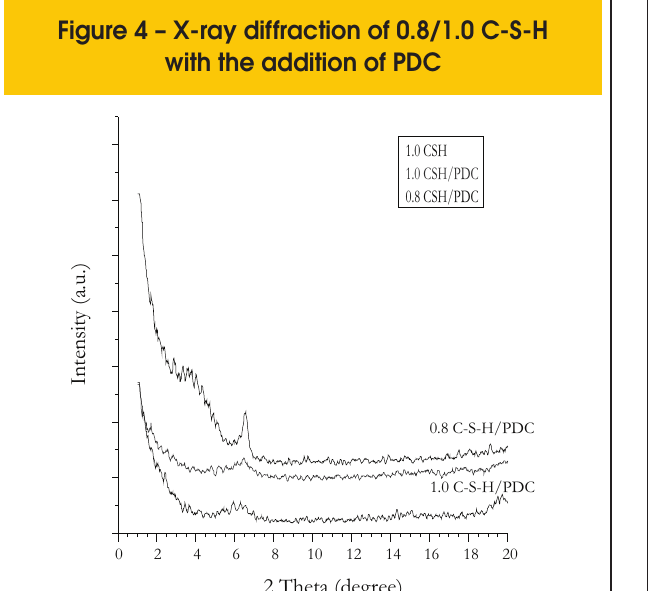
Figure 5 – X-ray diffraction C-S-H produced with the addition of